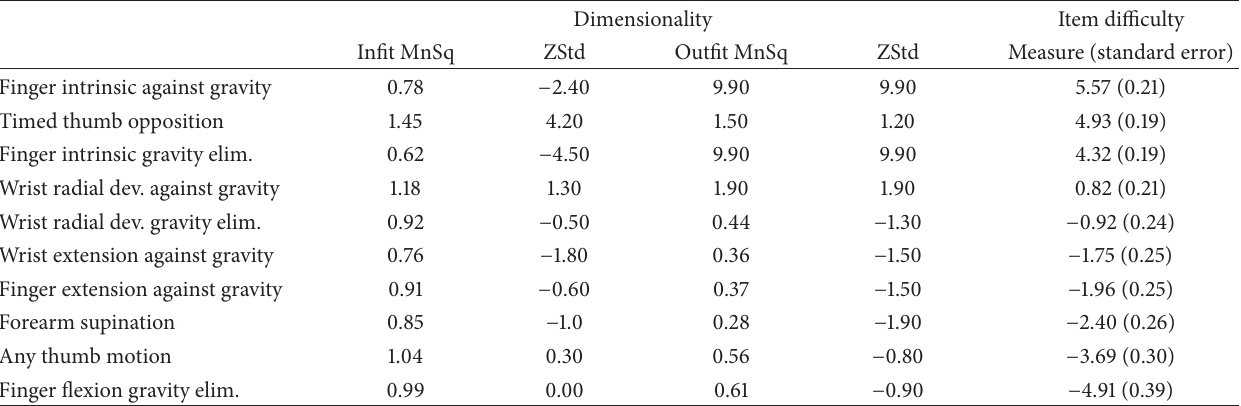
Table 5: Behavioral criteria statistics for 10-behavior short form of hand movements item.